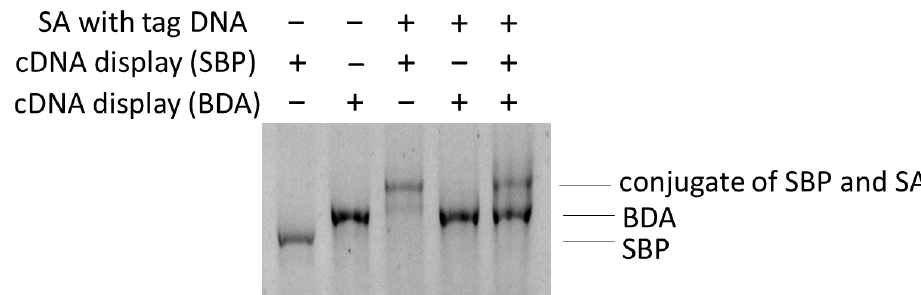
Figure 5. Model selection of binding peptides for SA. cDNA display molecules were incubated with SA modified with tag DNA in the presence of excess bovine serum albumin (BSA). After UV irradiation, samples were analyzed by PAGE. Although the cDNA display encoding BDA did not form a covalent crosslinked product with SA (compare lanes 2 and 4), the display encoding SBP did (compare lanes 1 and 3). When the two display molecules were mixed, only the SBP band showed upshifting, while that of BDA remained completely intact (lane 5). The two bands of lane 5 were dissected and analyzed by PCR.